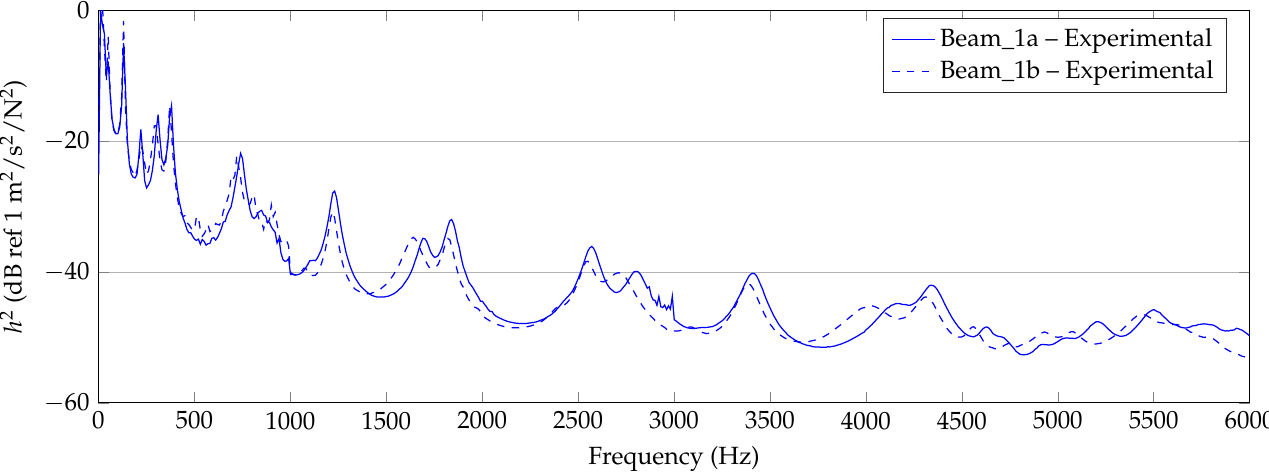
Figure 8. Experimental results of 1mm beam measurements (Beam_1a,